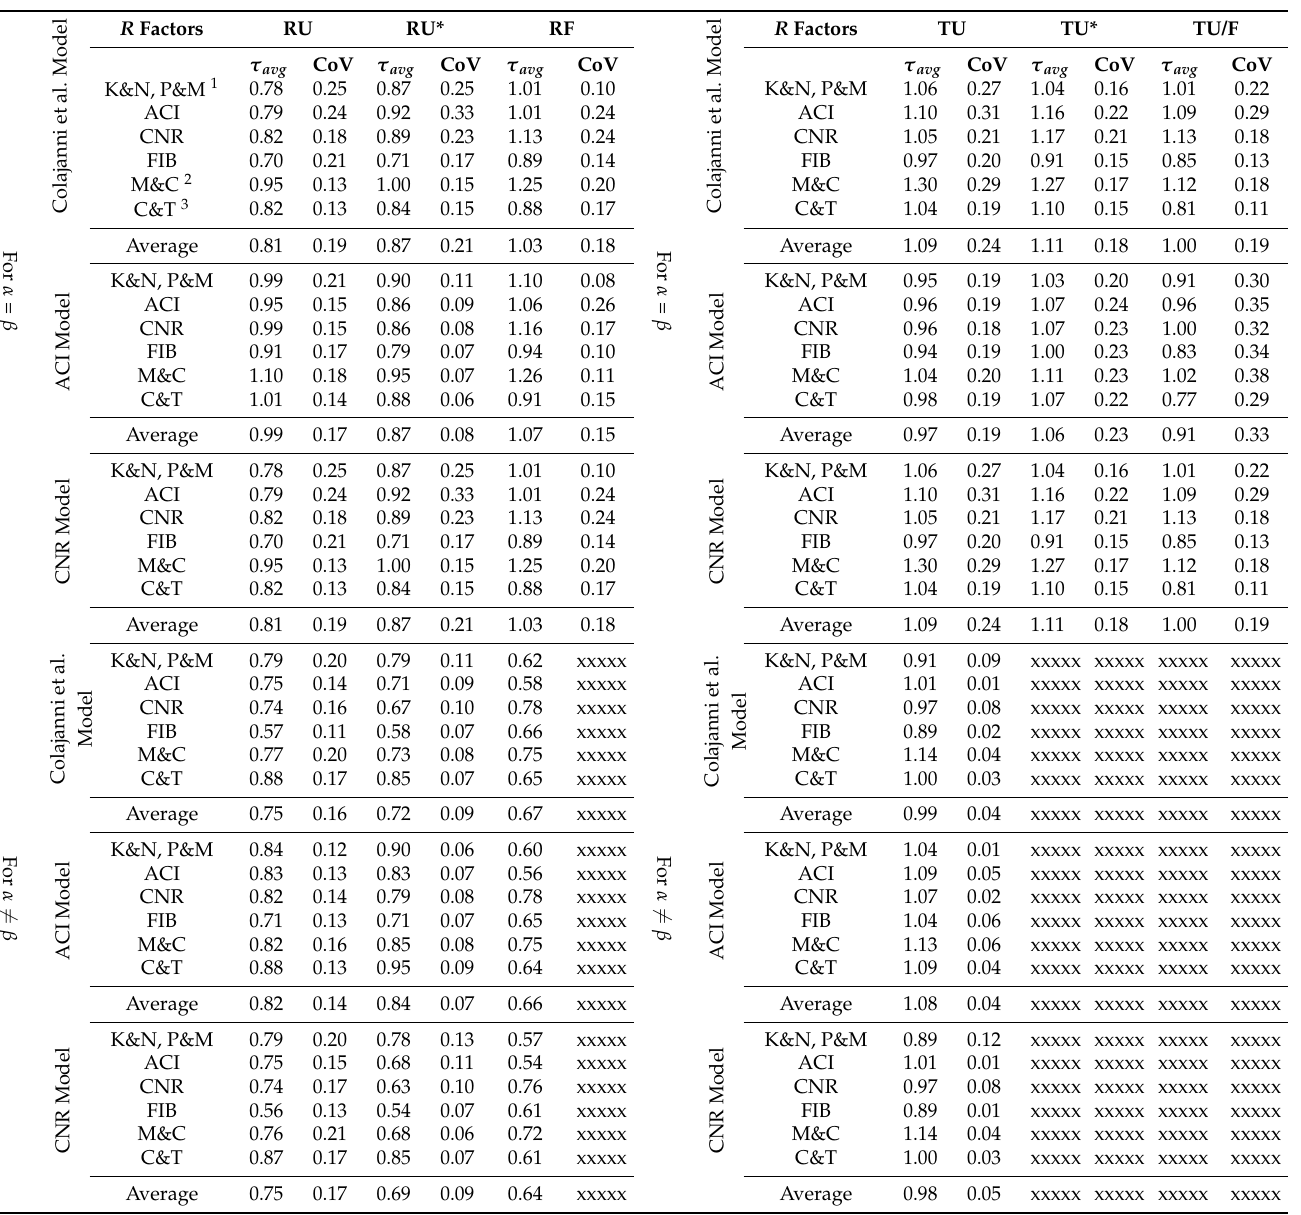
Table 2. Results of calculation on the basis of the 1st and 2nd approaches from Database 1 and Database